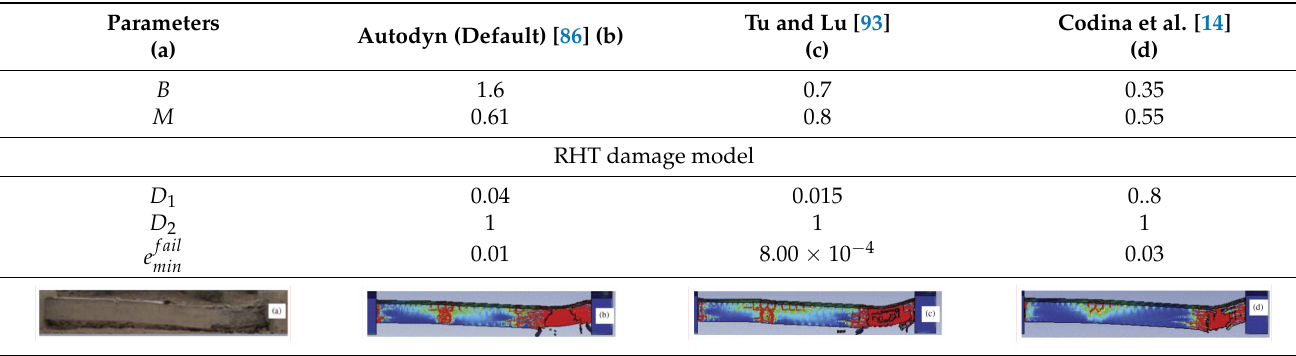
Table 6. Column damage obtained: (a) experimentally and numerically using (b) default RHT model parameters; (c) parameters provided in [93]; (d) modified parameters by